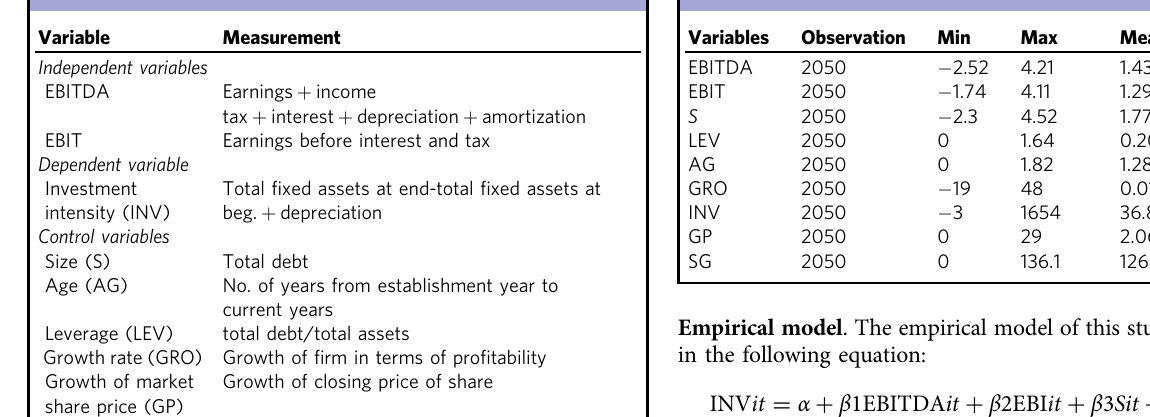
Table 2 Measurement of the variables. Table 3 Descriptive statistics by variables.